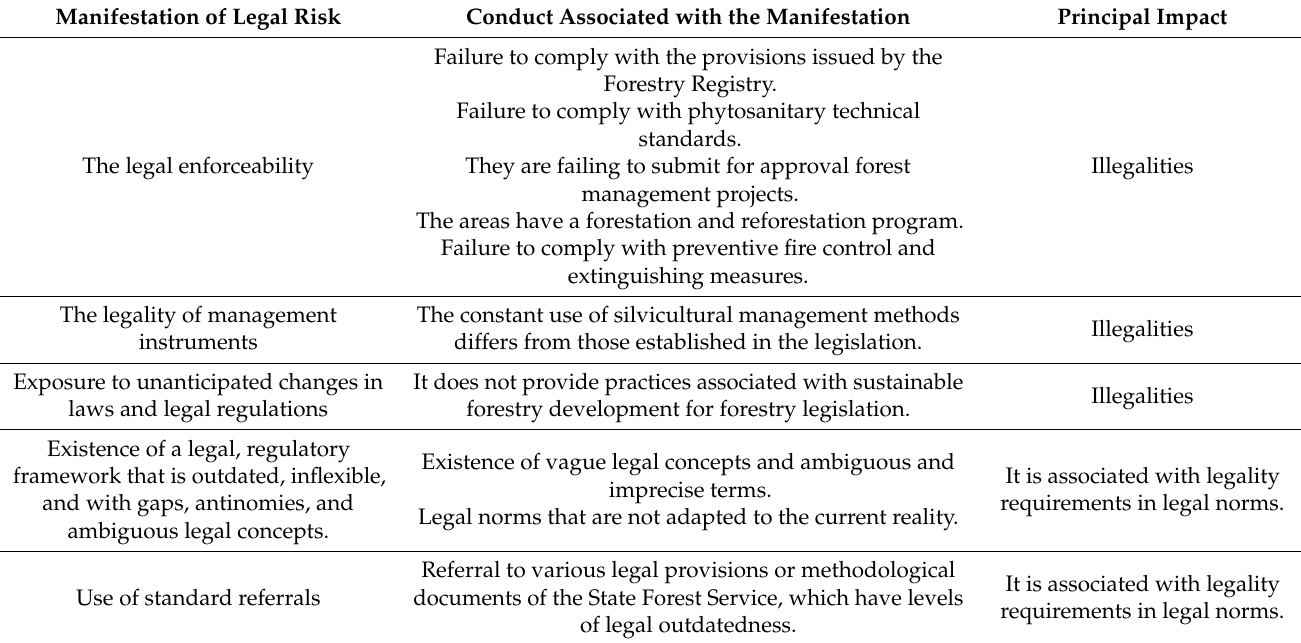
Table 3. Classification of legal risk manifestations and associated behaviors from the